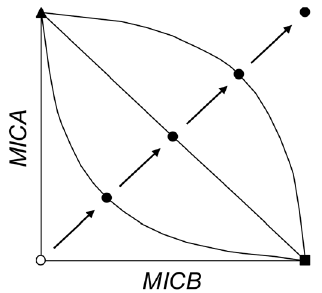
Figure 1. Tradeoffs in resistance to two antibiotics. Plot represents resistance as the minimal inhibitory concentration ( MICA N and MICB ) to the pair of drugs A and B. The three resistant bacteria R 1 ( m ), R 2 ( & ), and R 3 ( ) are depicted. R 1 is resistant only to drug A, and R 2 only to drug B. R 3 is double-resistant and four representatives are shown to denote different levels of tradeoffs. The MICA 3 and MICB 3 values for R 3 were derived as MICA 3 = (1– v ) ? MICA 1 and MICB 3 = (1– Figure 2. Effect of tradeoff strength on equilibrium X for v ) ? MICB 2 , where MICA 1 and MICB 2 are the minimal inhibitory different antibiotic treatments. Tradeoff strength is measured as concentrations of R 1 and R 2 against drugs A and B, v is the tradeoff the parameter v (Figure 1). The equilibrium frequency of uninfected parameter, and 0 # v # 1. With the highest tradeoff constraint and v =1, patients X ˆ was determined by running simulations of the model until all MICA 3 and MICB 3 equal zero and are same as the MICA S and MICB S frequencies were stable. In cases where the values fluctuated, the values for sensitive S bacteria ( # ). As v is decreased from 1.0, 0.75, 0.50, equilibrium frequency was the average for the cycles. All simulations 0.25 to 0, the progression ( R ) represents the double-resistant R 3 were run with parameter values of MICA 1 = MICB 2 =240; MICA S = experiencing less and less tradeoff. The solid lines ( ) through three of MICB S = MICA 2 = MICB 1 =0; MICA 2 and MICB 3 as defined in Figure 1; the R 3 points represent families of mutants that connect R 1 and R 2 and Q max =0.25; Q min =–0.25; c =0.1; s =0.25; b =1.0; and c =0.25. These have the same approximate level of tradeoff. If v =0.5, the tradeoff is values are in the range of the numbers used by Bergstrom et al. and linear. Our examination of tradeoffs uses R 3 as the representative of the Regoes et al. During simulations, an MIC with a value of zero was reset family. N to 0.000001 to avoid division by zero in Equations 6–8. Treatments: ); SINGLE ( # ); CYCLING ( p =50, m ); MIXING NONE ( ); CONTROL ( ( p =50, m ); Combined COCKTAIL ( % ); Separate COCKTAIL ( & ). Our analysis included values of p greater and smaller than 50 for CYCLING and MIXING, but the data are not presented to avoid crowding the figure. We note here that if p =1, Xˆ values in both treatments became indistinguishable from those in MIXING with p =50 and for all sampled values of v . If p was increased above 50, Xˆ values in CYCLING converged downwards to match those in SINGLE, while in MIXING they decreased to match those in CYCLING ( p =50). The largest value examined was p =50,000. The matching of MIXING ( p =50,000) and CYCLING ( p =50) is graph by using the line pattern to represent the most common bacterium in the population; S (– – –); R 1 and/or R 2 ( ? ? ? ); R 3 (—).